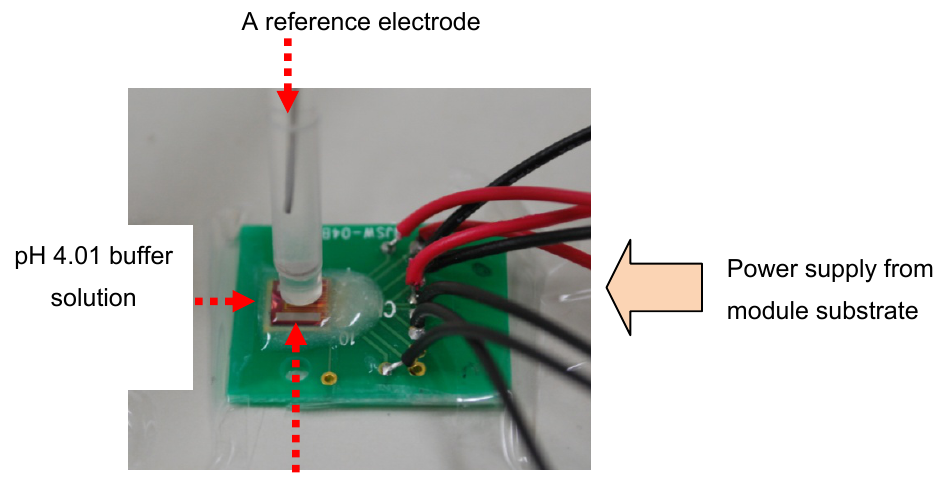
Figure 9. Photograph of the measurement set up for the multimodal sensor chip.